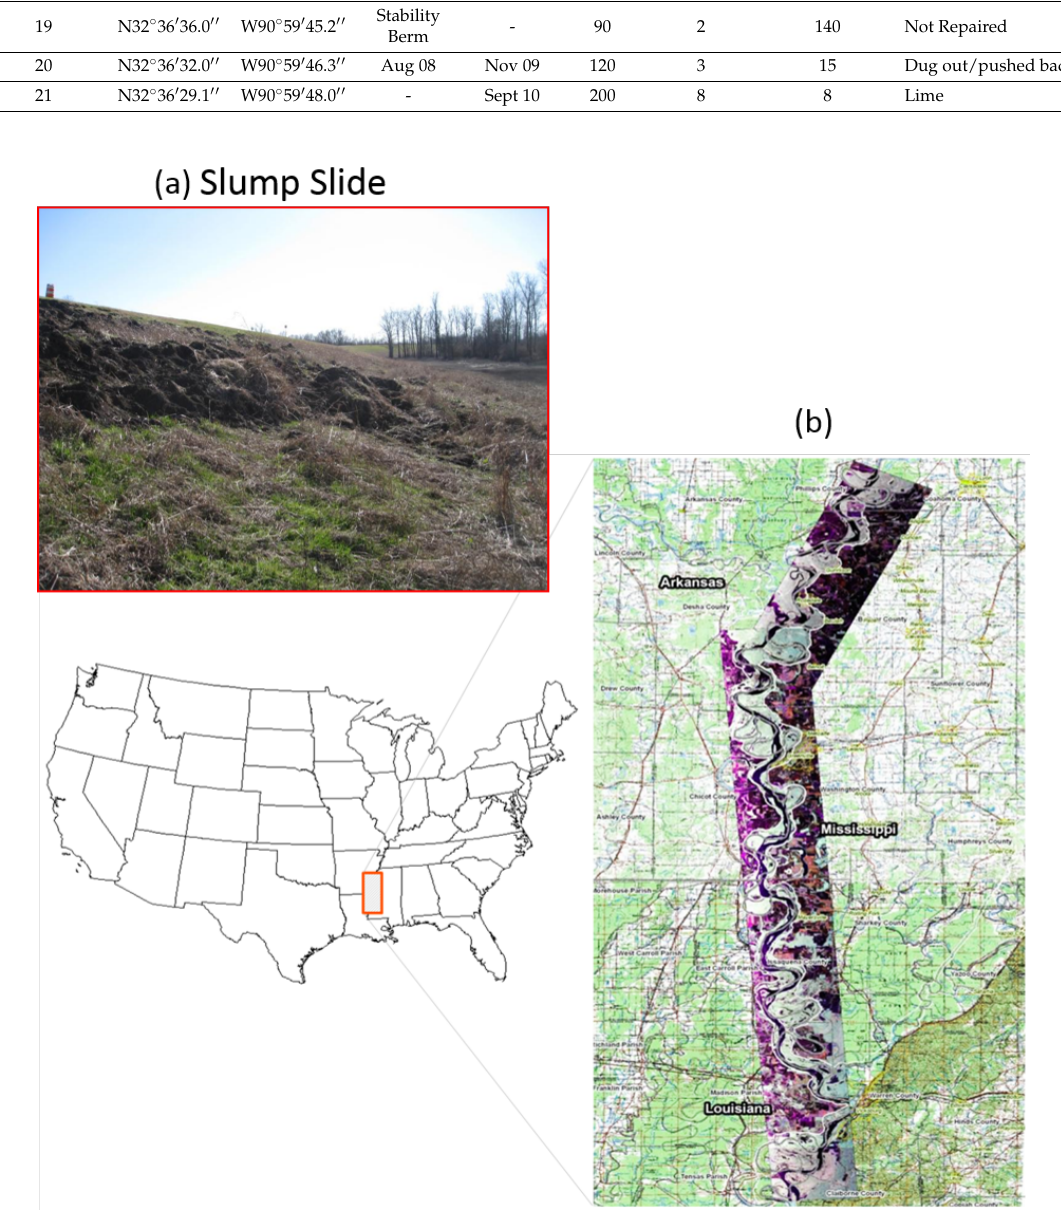
Figure 3. Map and pictures of study area. ( a ) Picture of levee slump slide; ( b ) Study area